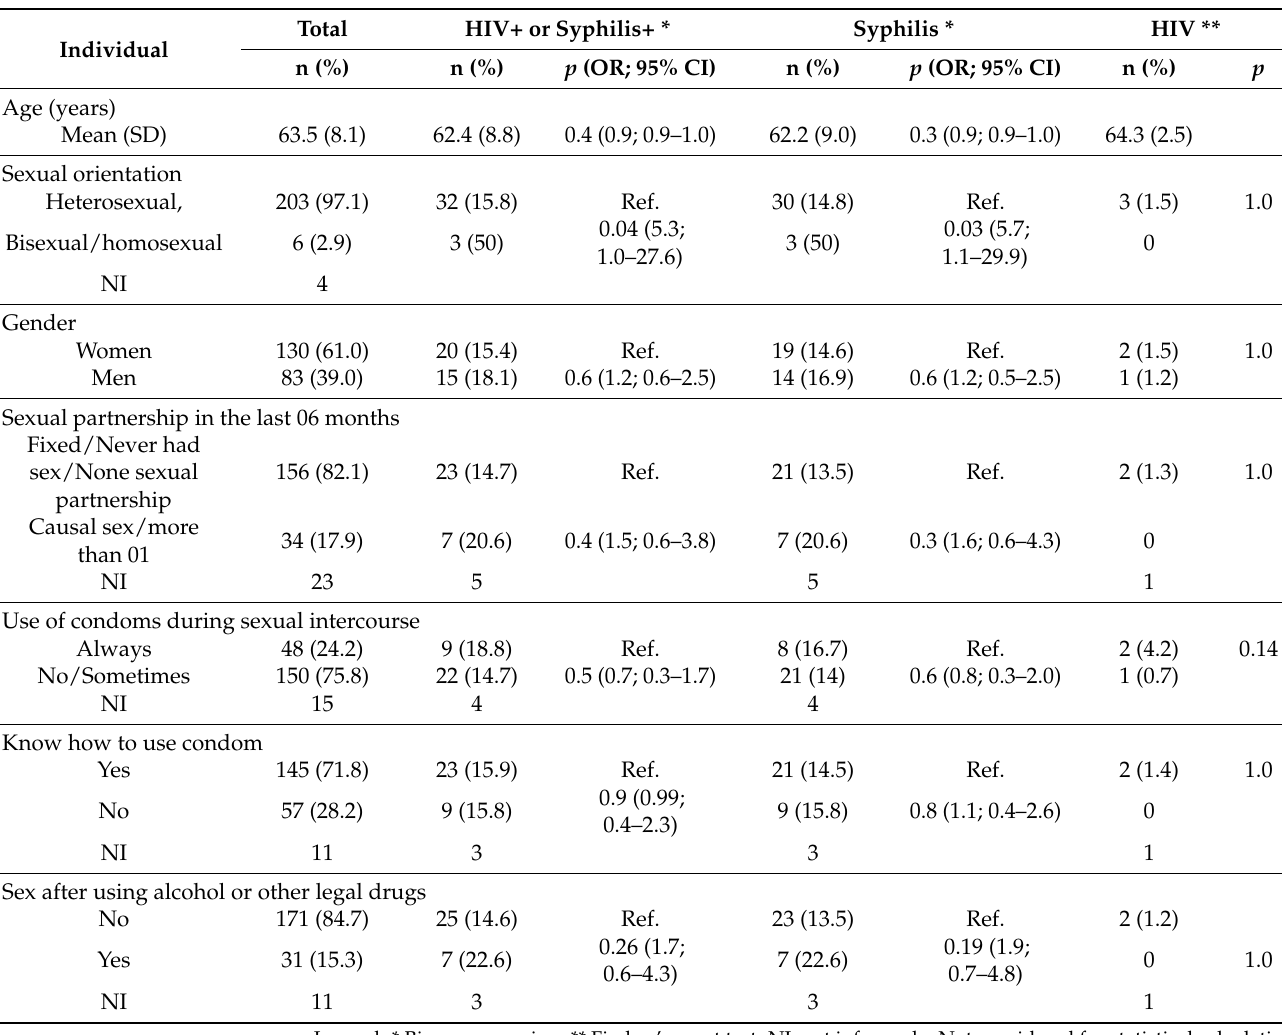
Table 3. Individual factors associated with sexually transmitted infections in older people in a subnormal agglomeration in the Brazilian Amazon.